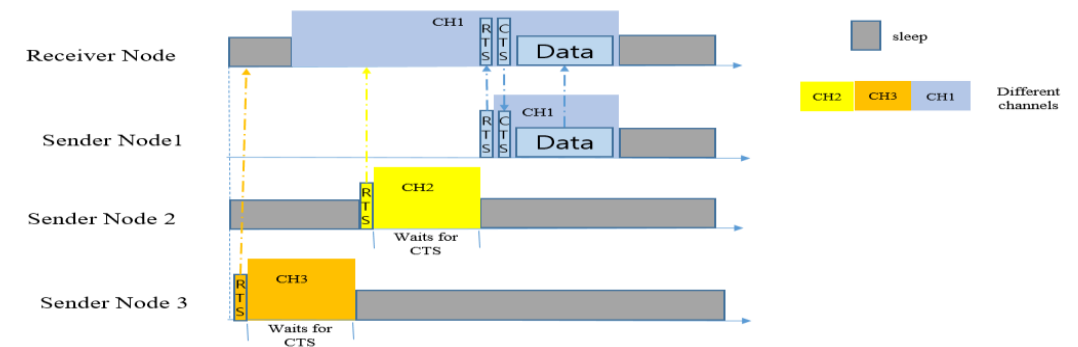
Figure 18. Contention and channel-hopping in LEOR [17].